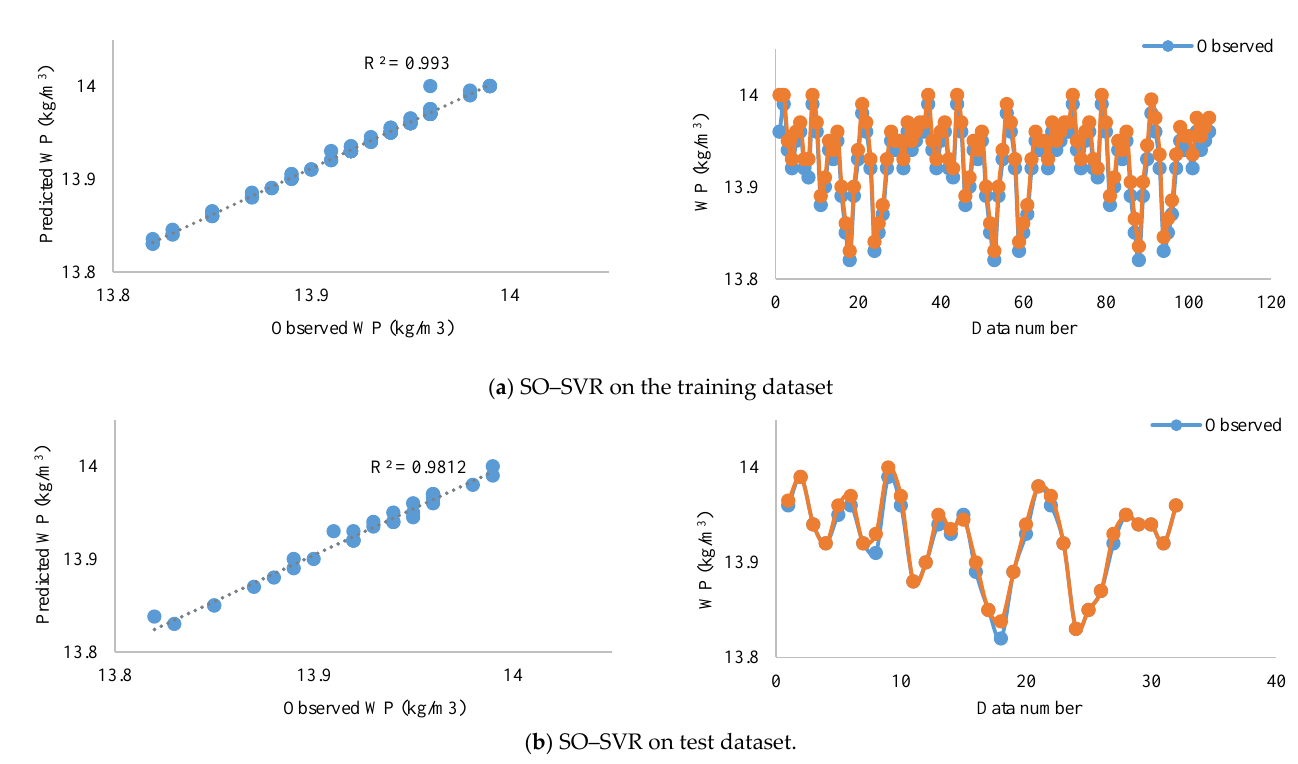
Figure 7. ( a – d ) Comparison of predicted yield with observed results in the training and test stages.